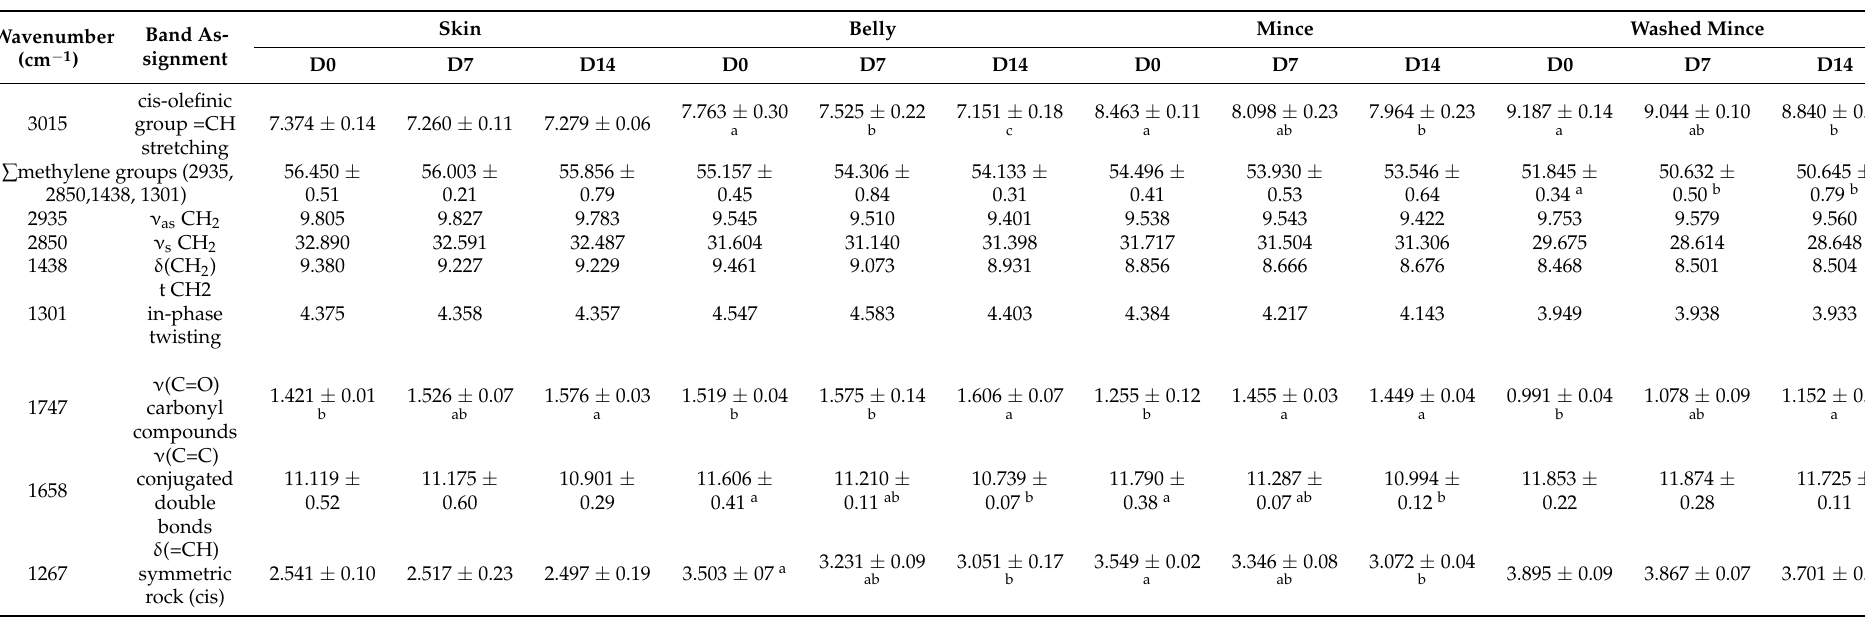
Table 4. Relative integrated intensity of selected regions of Raman spectra of lipids extracted from various tissues of silver carp during ice storage and their respective washed minces.